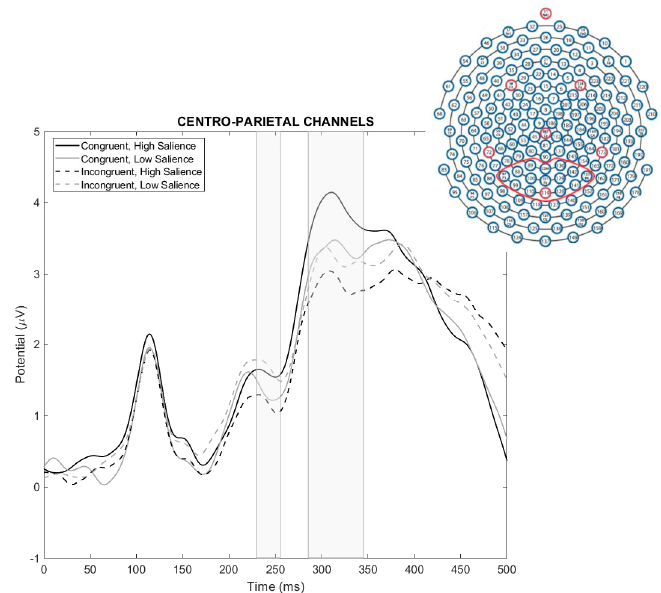
Figure 2. Grand averaged ERP waveforms for each of the four congruency × salience experimental conditions, over centro-parietal channels (circled in red in the electrodes schematic, top right corner). Grayed areas correspond to time periods showing a significant congruency × salience interaction.